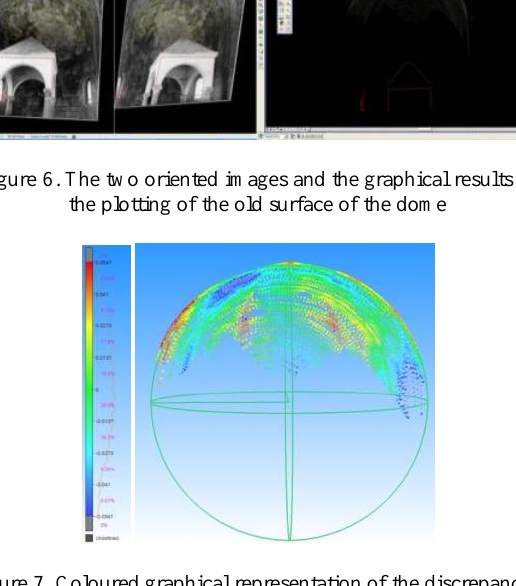
Figure 7. Coloured graphical representation of the discrepancies between the interpolated sphere and the surveyed